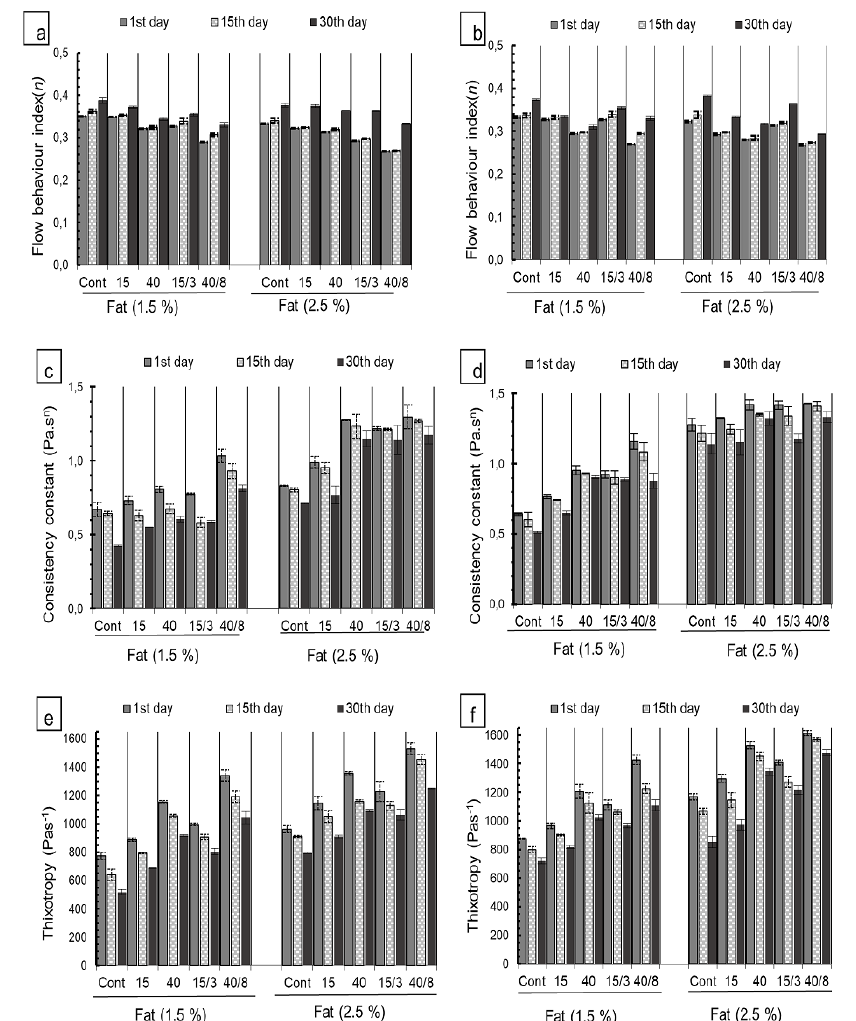
Figure 4. (a) flow behaviour index, (c) consistency constant and (e) thixotropy values of the ayran samples produced from milk heat treated at 95°C for 90 s. (b) flow behaviour index, (d) consistency constant and (f) thixotropy values of ayran samples produced from milk heat treated at 95°C for 300 s. The bars represent mean values, and the error bars represent standard error of the